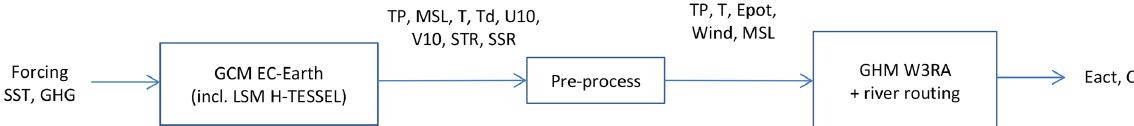
Figure 3. Flowchart illustrating the methodology of this study, including the global climate model, the global hydrological model, and the related variables: total precipitation (TP), mean sea level pressure (MSL), temperature at 2m ( T ), dewpoint temperature at 2mr ( T d ), wind component x direction at 10m ( U 10 ), wind component y direction at 10m ( V 10 ), surface solar radiation (SSR), surface thermal radiation (STR), potential evaporation ( E pot ), actual evaporation ( E act ), and discharge ( Q ).